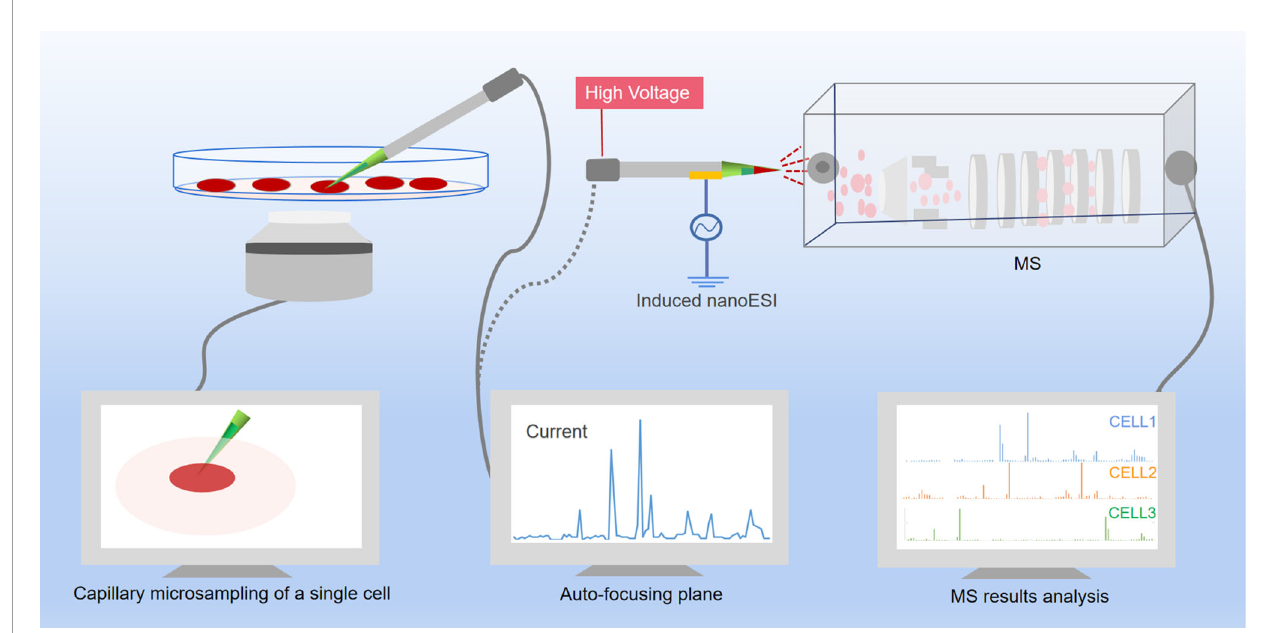
FIGURE 3 | Scheme of single-cell metabolomics analysis of live cell. The content of a live single cell is extracted by micropipette needle under the guidance of an inverted micro-scope, and a cell manipulation system was used to control the micropipette needle to aim the targeted cell. After assistant solvent was added to the sampling tip, the biomolecules were dissolved into the assistant solvent and immediately ejected from the tip into the MS under the impetus of the electric fi eld. The raw data then analyzed by